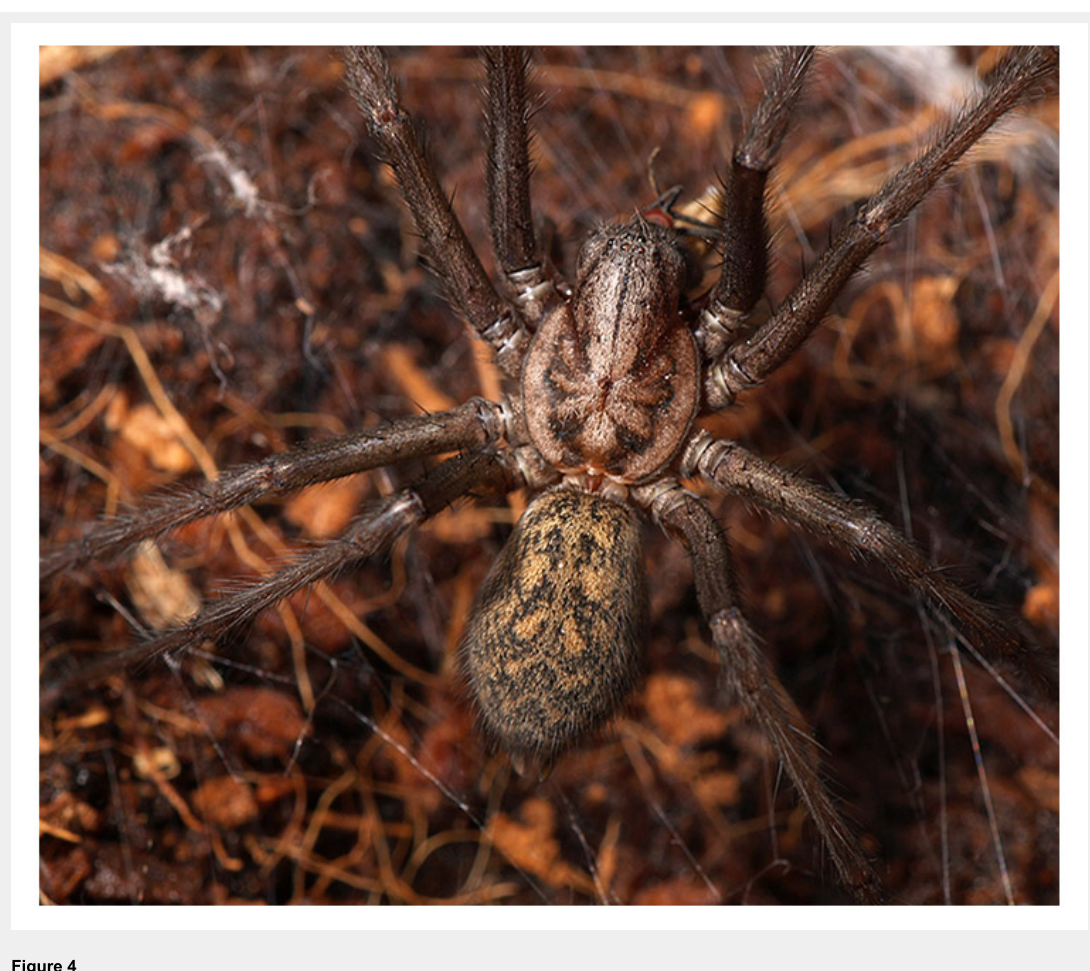
Figure 4 Tegenaria atrica, female (source: Sarefo, Wikimedia